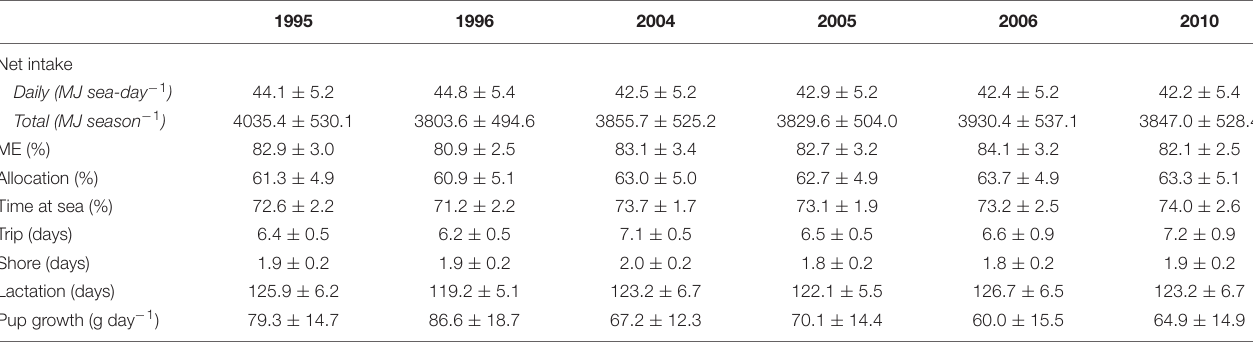
TABLE 2 | Summary of bioenergetic model simulations for lactating females in each year, including mean ( ± SD ) net energy intake, percentage of energy intake available for metabolism (ME), percentage of total energy intake allocated to a female’s metabolic overhead (Allocation), percentage time at sea, trip, shore, and lactation durations, and pup growth rates.